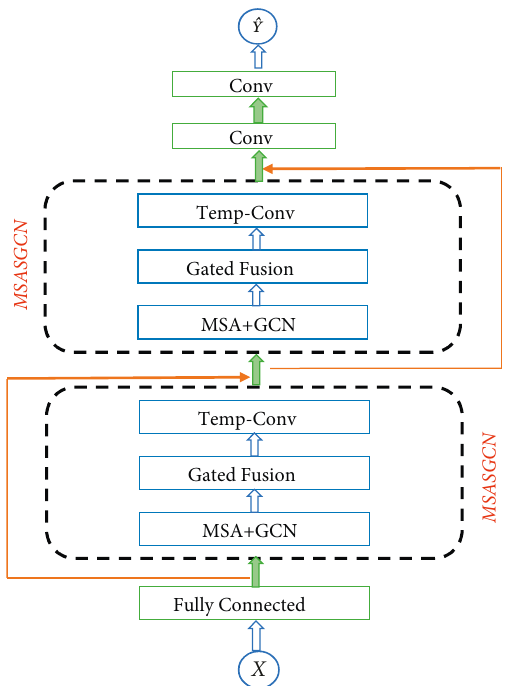
Figure 3: Architecture of MSASGCN. MSA :Multi-head self-at- tention; GCN:graph convolutional network; Temp-Conv : temporal convolution; Conv: